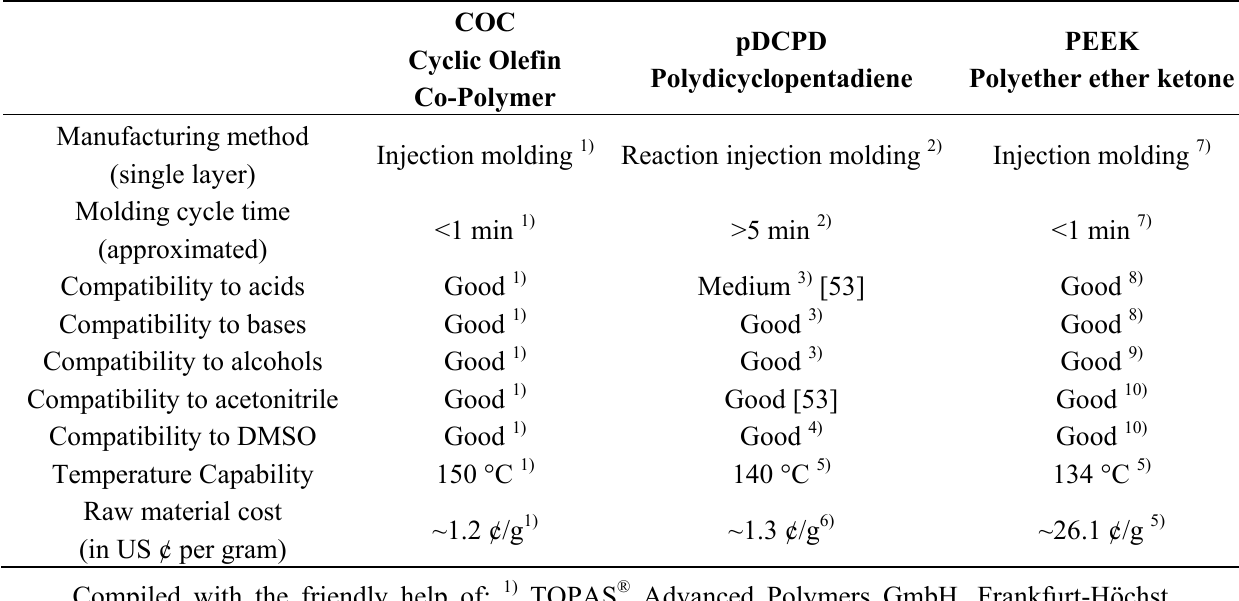
Table 1. Comparison of polymers utilized for microfluidic chip manufacturing with a view on applications in